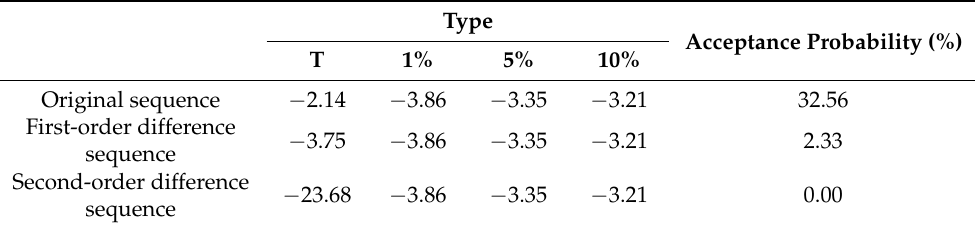
Table 4. The ACF verification